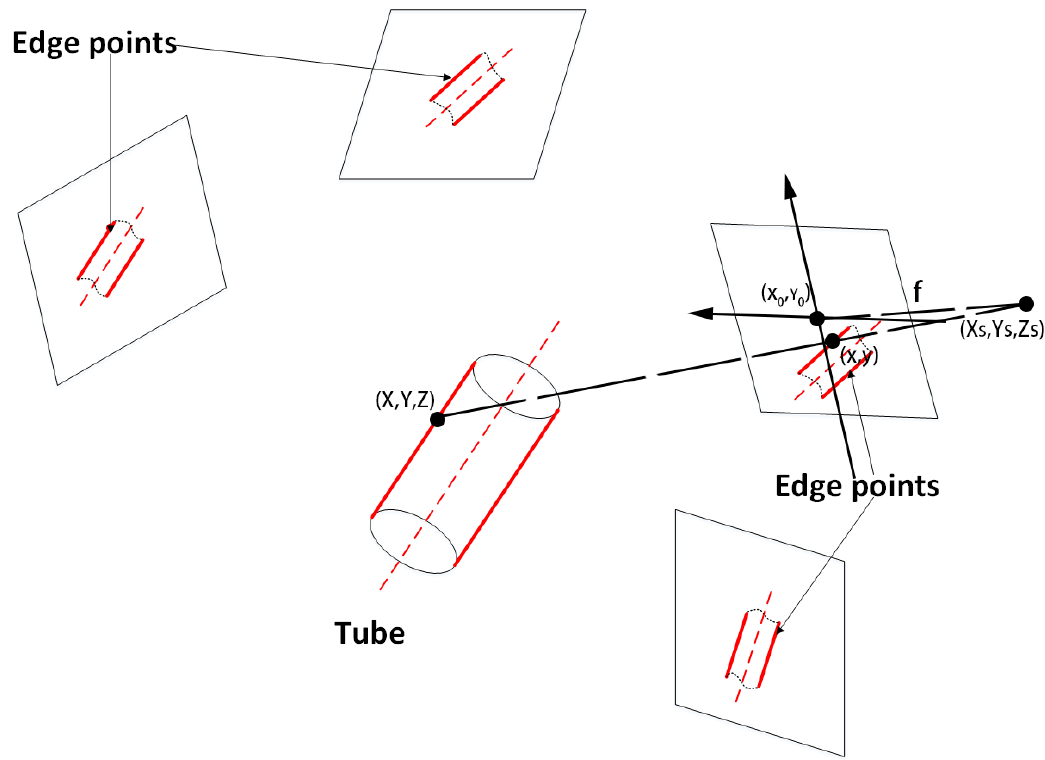
Figure 8. Cylinder fitting.